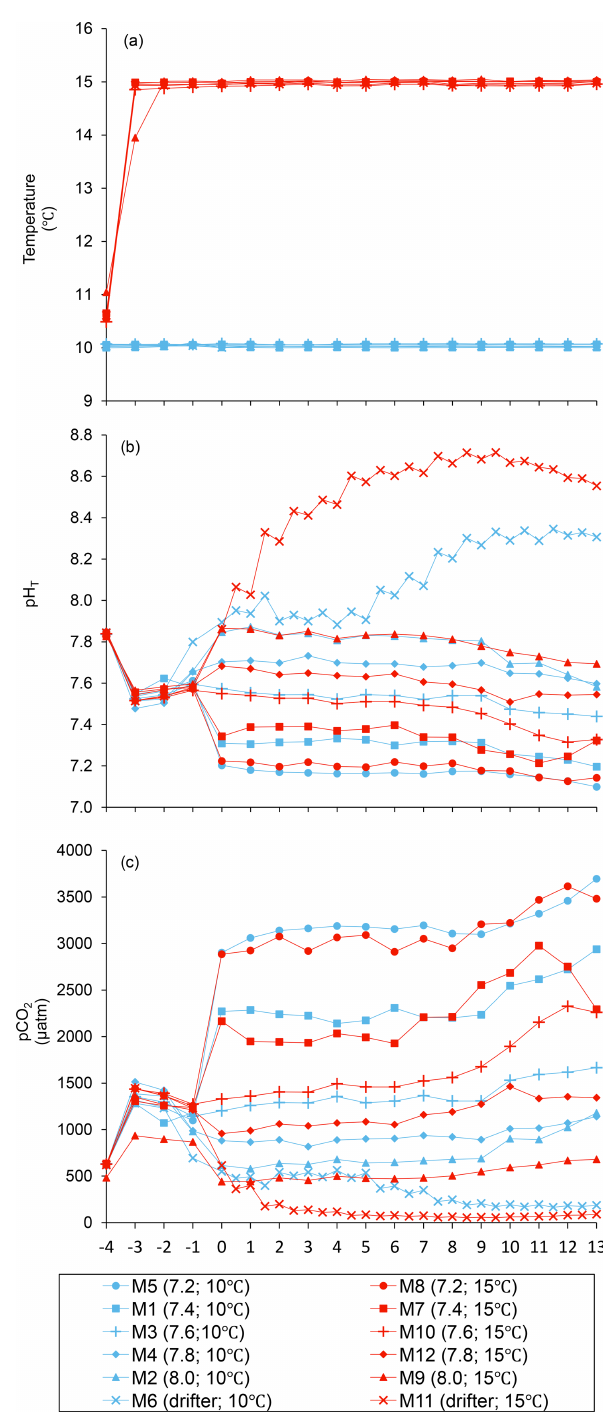
Figure 1. Temporal variations over the course of the experiment for (a) temperature, (b) pH T , and (c) p CO 2 . For symbol attribution to treatments, see the legend. Adapted from Bénard et al.